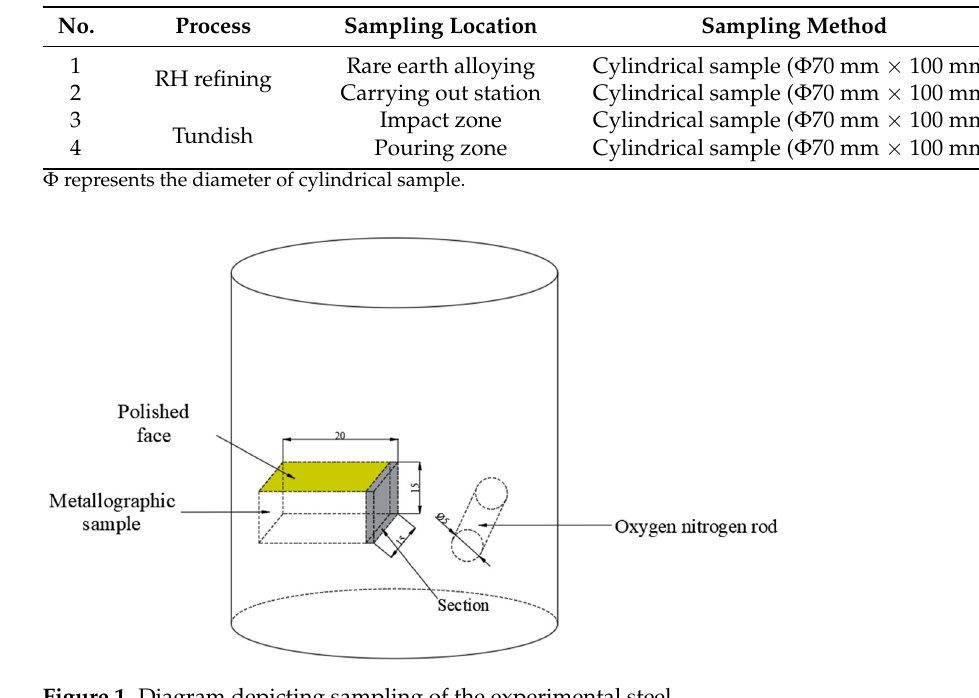
Figure 1. Diagram depicting sampling of the experimental steel. The magnetic flux density, B 50 , was determined at a magnetic field strength of H = 5000 A/m, and the core losses, P 15/50 , at an induction of 1.5 T and 50 Hz. Magnetic measurements were carried out for final-annealed sheets of 30 mm in width and 100 mm in length, in both rolling and transverse directions. The measured values were averaged to align with the Epstein method, using MPG100D equipment (Dr. Brockhaus Messtechnik GmbH & Co. KG, Lüdenscheid, Germany).